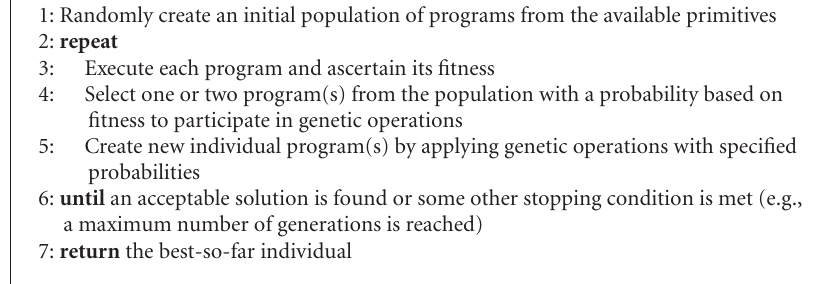
Algorithm 1: Genetic programming basic algorithm [27].